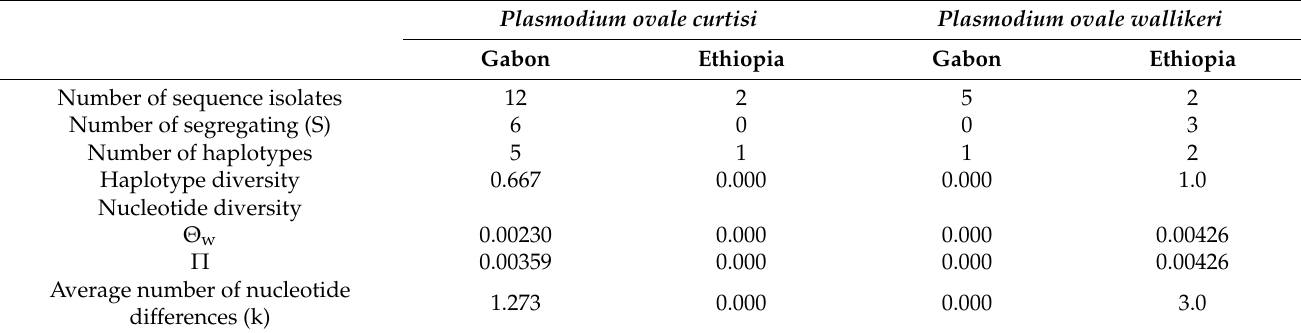
Table 2. Genetic diversity of Po curtisi and Po wallikeri in Gabon and Ethiopia using the small subunit ribosomal RNA